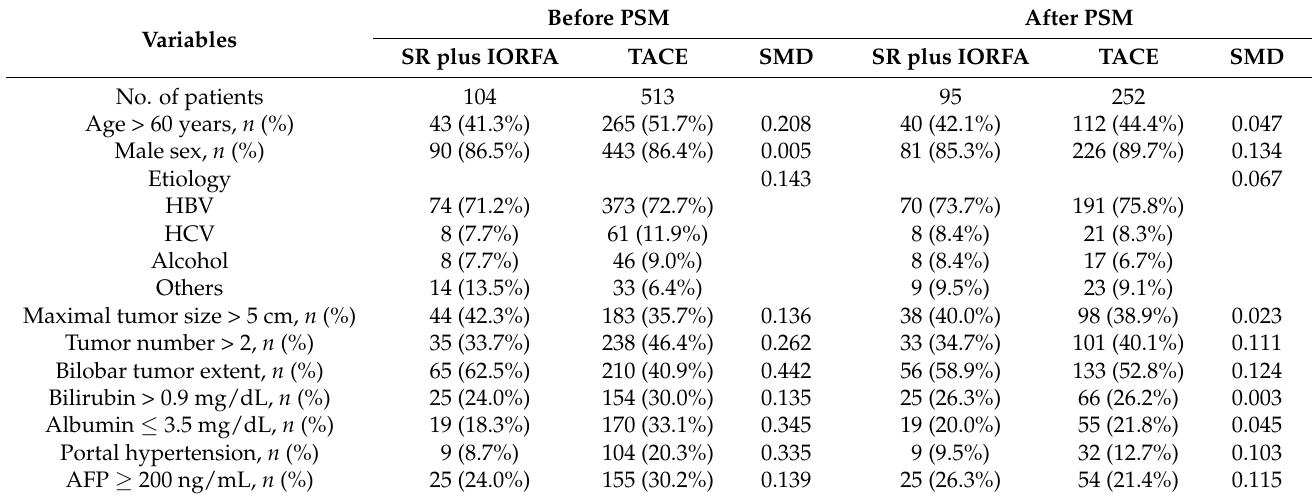
Table 1. Demographic and clinical characteristics of patients before and after propensity score matching.